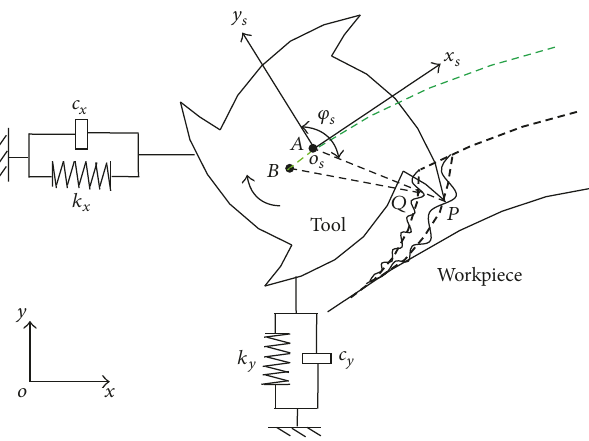
Figure 2: Schematic diagram of the proposed dynamic model describing a peripheral milling system.